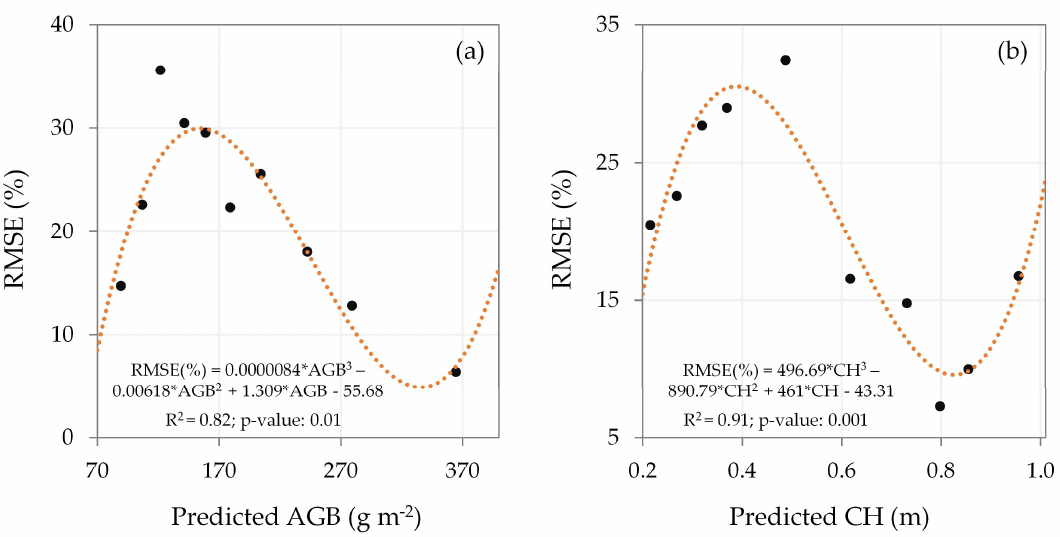
Figure 9. Relative RMSE uncertainty (in %) of the estimated aboveground biomass (AGB) ( a ) and canopy height (CH) ( b ), with the polynomial function fitted.